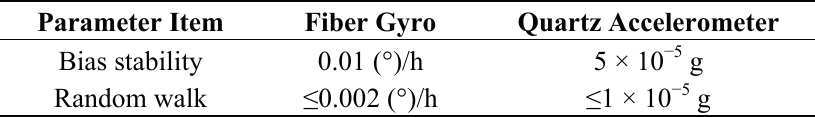
Table 5. The main parameters of inertial components for FOG-INS.